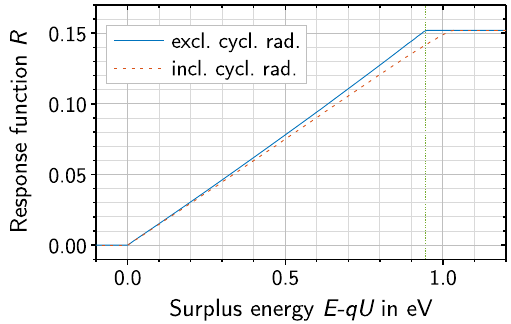
Fig. 14 The impact of energy losses due to cyclotron radiation on the shape of the response function near the transmission